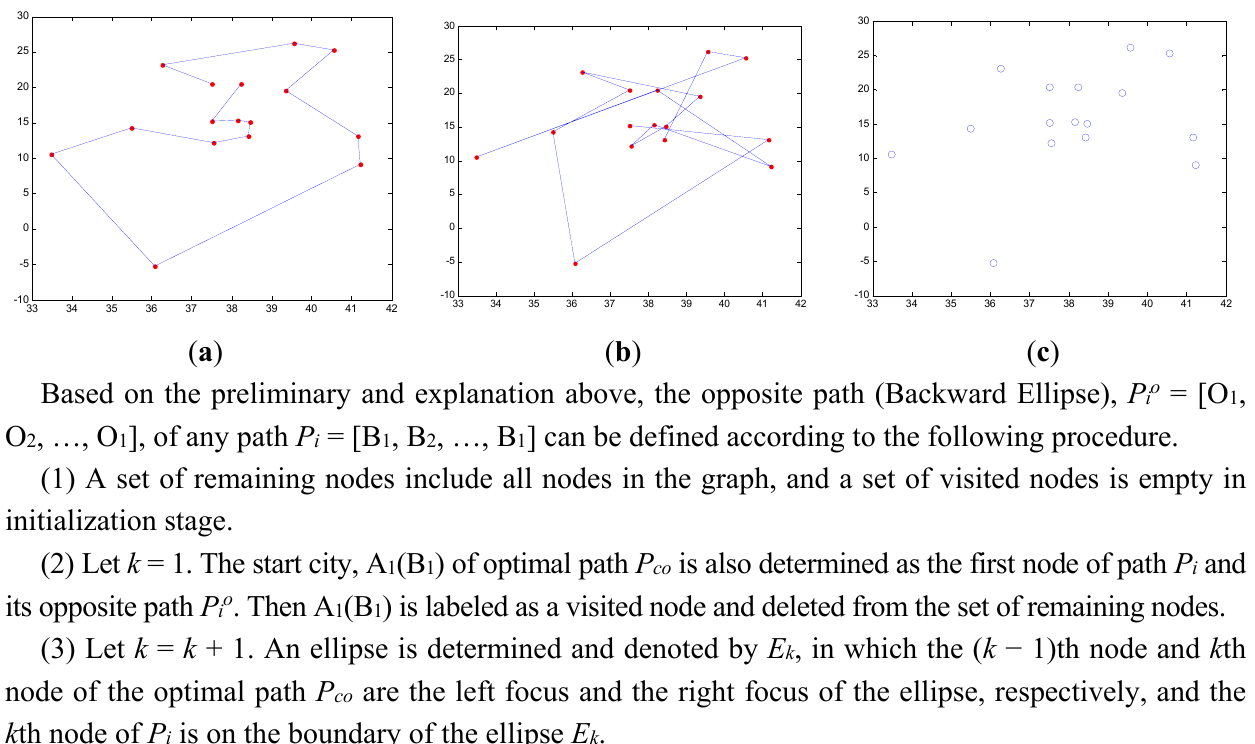
Figure 4. Component elements of opposite path (Backward Ellipse). ( a ) Optimal path in the current population. ( b ) Candidate path. ( c ) Cities in the